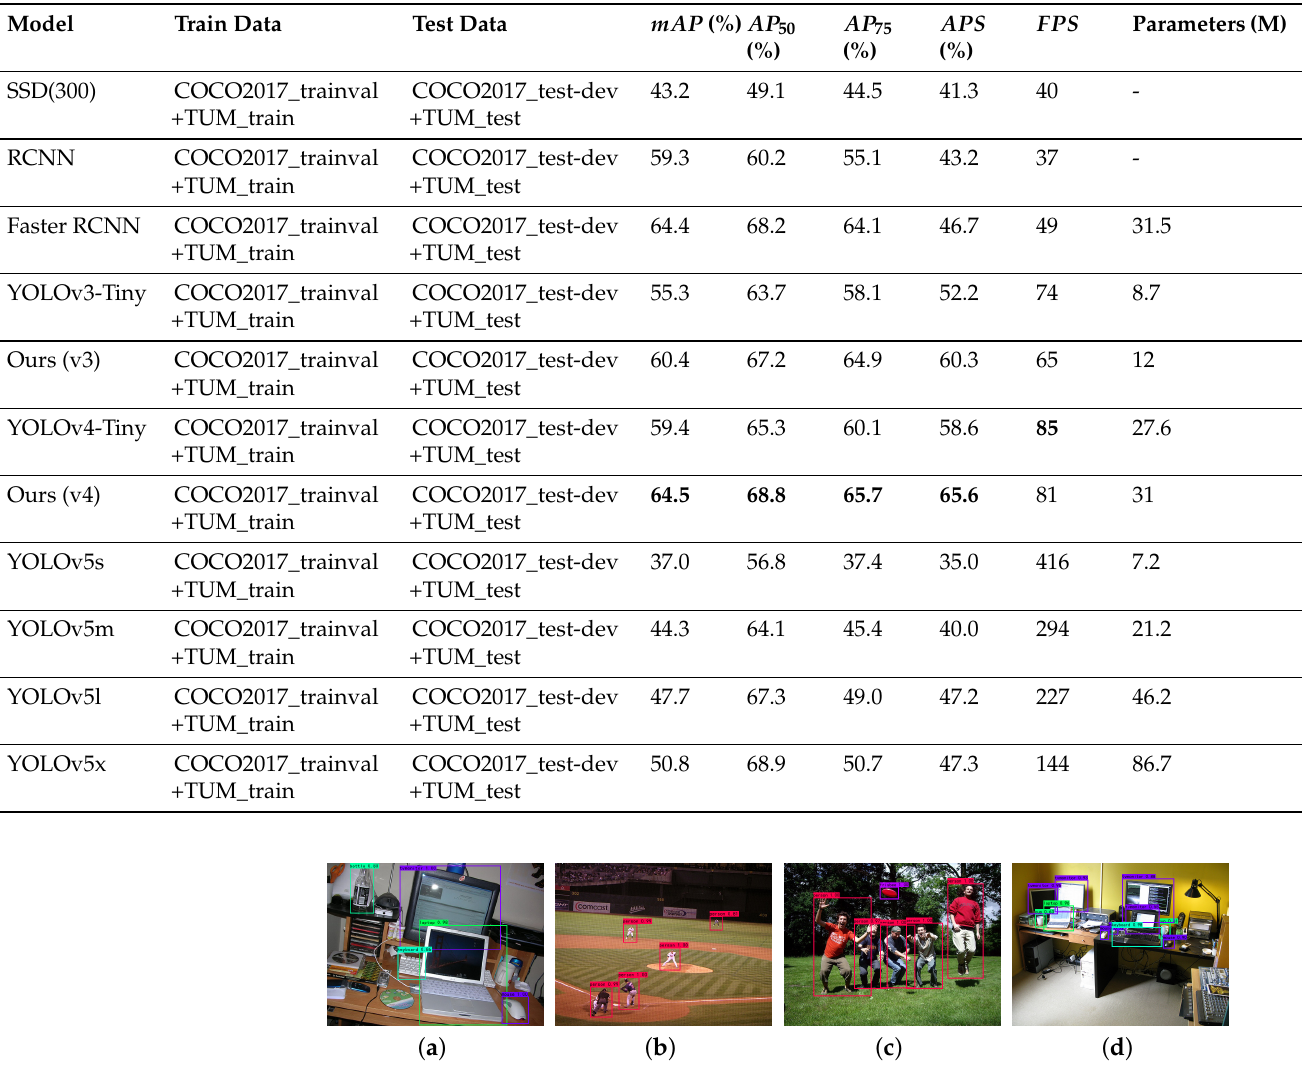
Table 4. AP values and speed of different networks on COCO+TUM dataset.